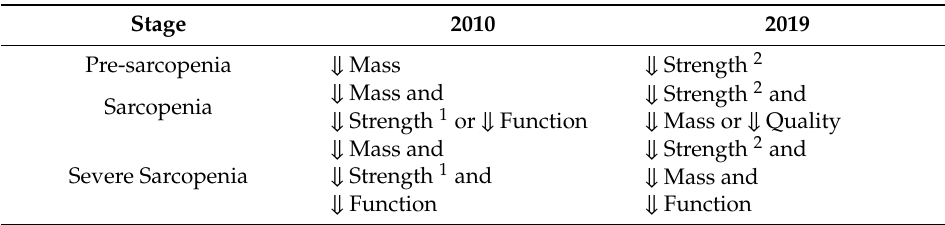
Table 1. Comparison of European Working Group on Sarcopenia in Older People (EWGSOP) 2010 and 2019 diagnosis criteria of